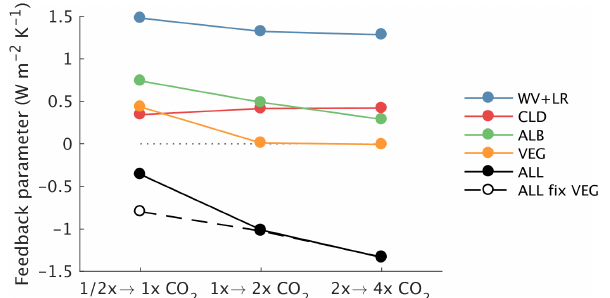
Figure 24. State dependence of global feedback parameters for CLIMBER-X. The feedbacks are for CO 2 doubling starting from different initial CO 2 concentrations (140, 280 and 560ppm, from left to right). The feedbacks are computed from simulations where vegetation is prescribed at its pre-industrial state. The vegetation feedback is diagnosed from the difference in the sum of all feed- backs between simulations with dynamic and fixed vegetation. The sum of all the feedbacks also includes the contribution from the Planck feedback, which is not